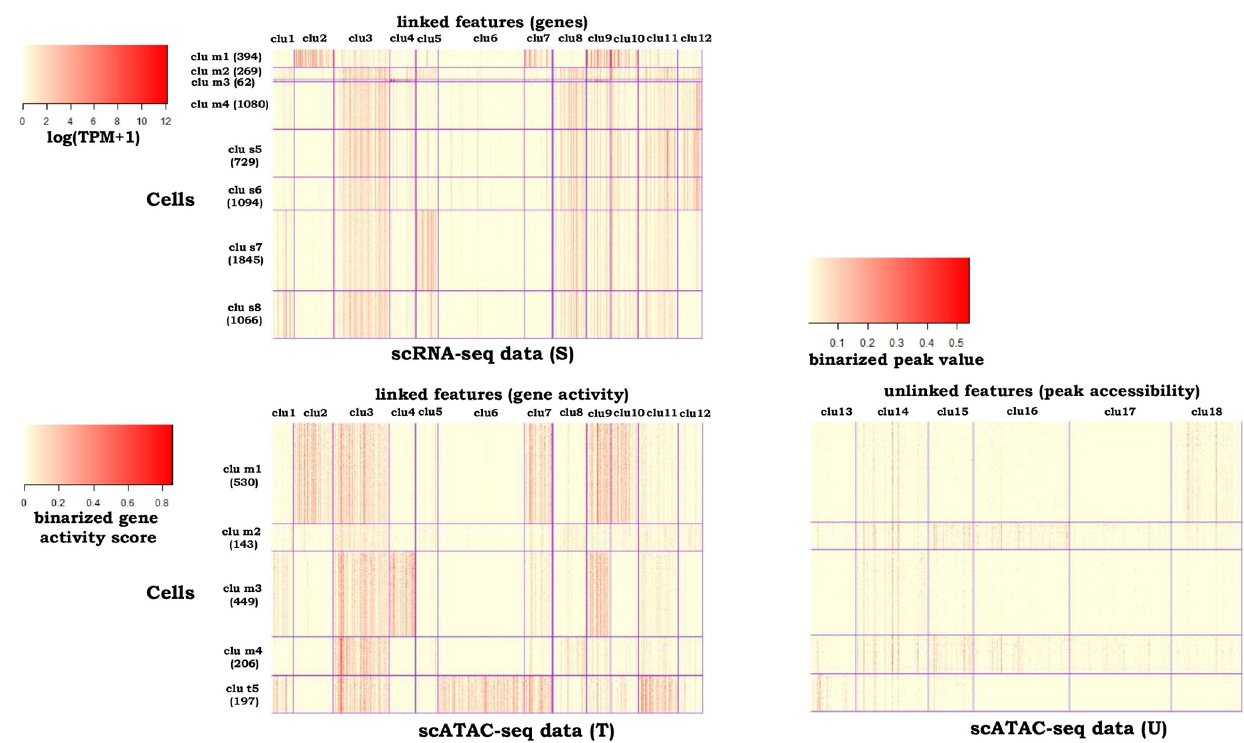
Fig 2. Heatmaps of the clustering results by couple CoC+ for example 1. “clu m” represents the matched cell cluster across the source data and the target data. “clu s” and “clu t” represent the cell clusters that are unique to the source data and the target data, respectively. For better visualization, we randomly averaged every 15 cells within the same cell cluster to generate pseudocells for every